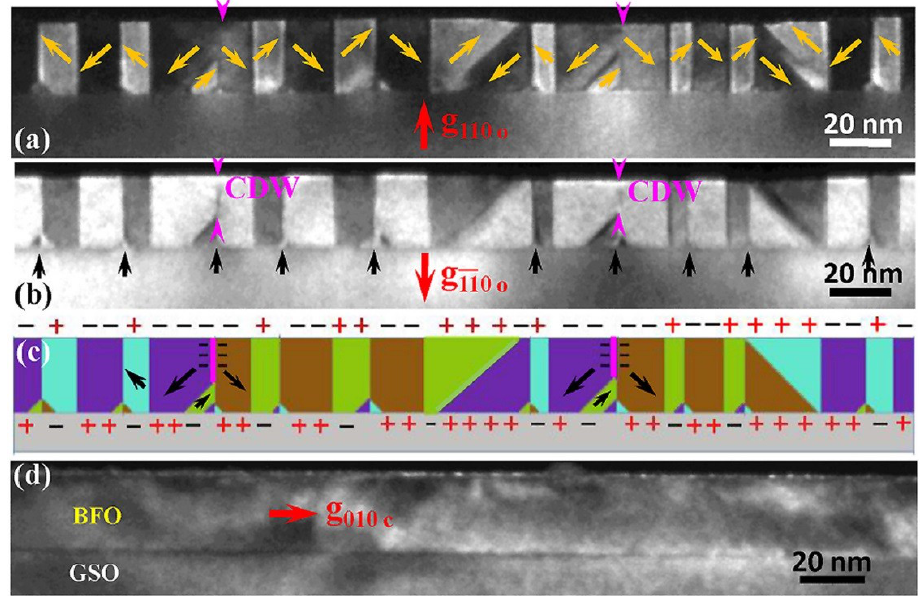
Figure 12. Dark-field transmission electron microscopy (TEM) images of a 24-nm thick BFO film on GSO substrate taken with near two beam ( a ) g = 110 ( c ) a schematic of domain structures in ( a ) and ( b ); ( d ) dark-field image near [001] axis using g = 010 . (Reprinted with permission from [57]. Copyright 2013 American c Institute of